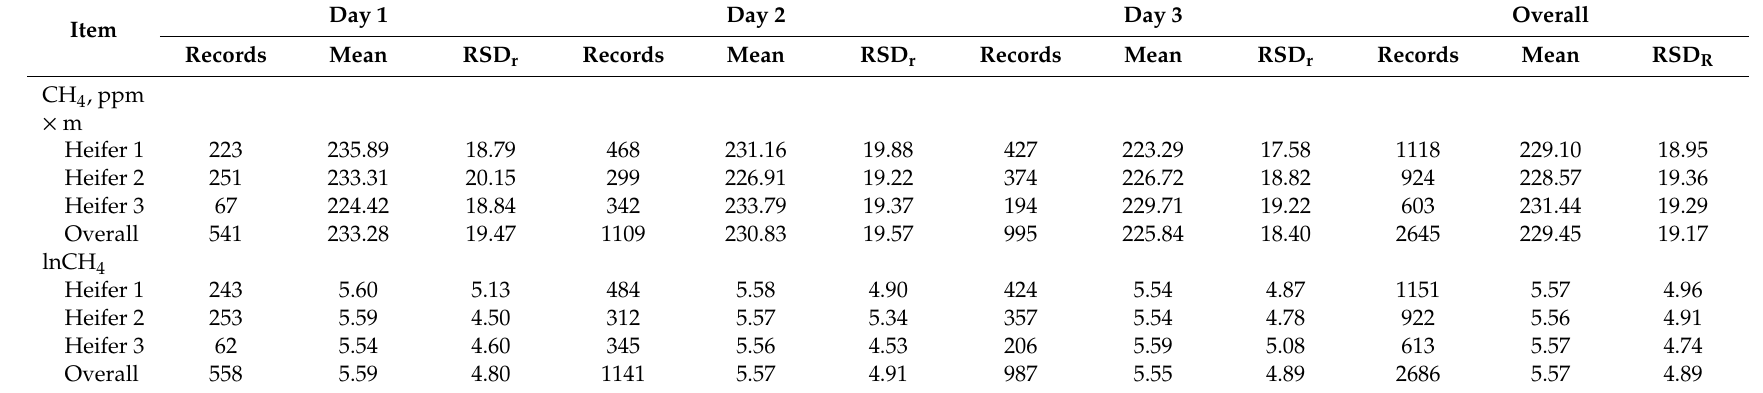
Table 4. Number of records, mean, repeatability relative standard deviation (RSD r , %) calculated within the day on five measurements, and reproducibility